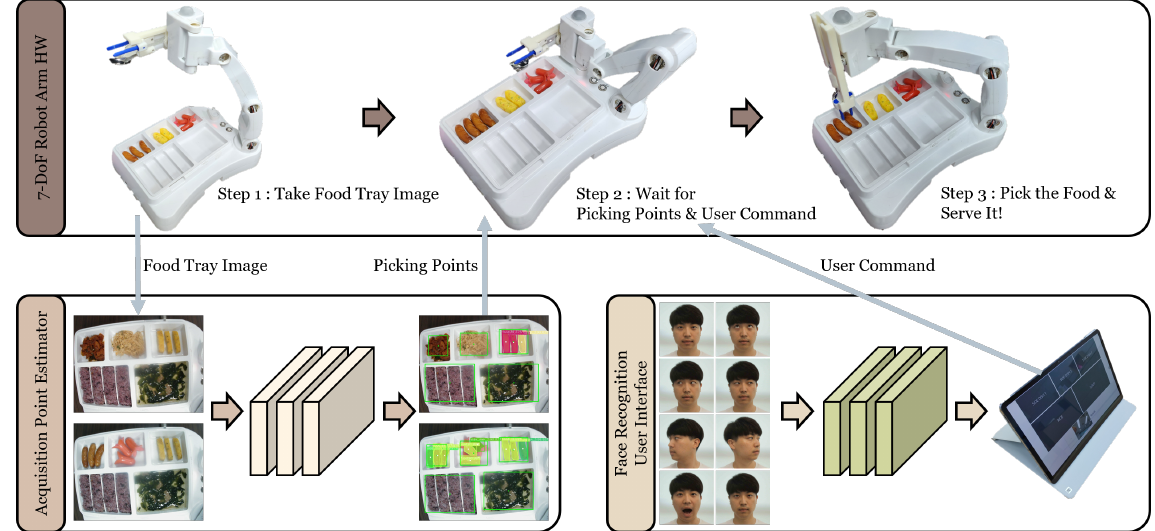
Figure 2. The overall flowchart of the meal-assistance process proposed in this